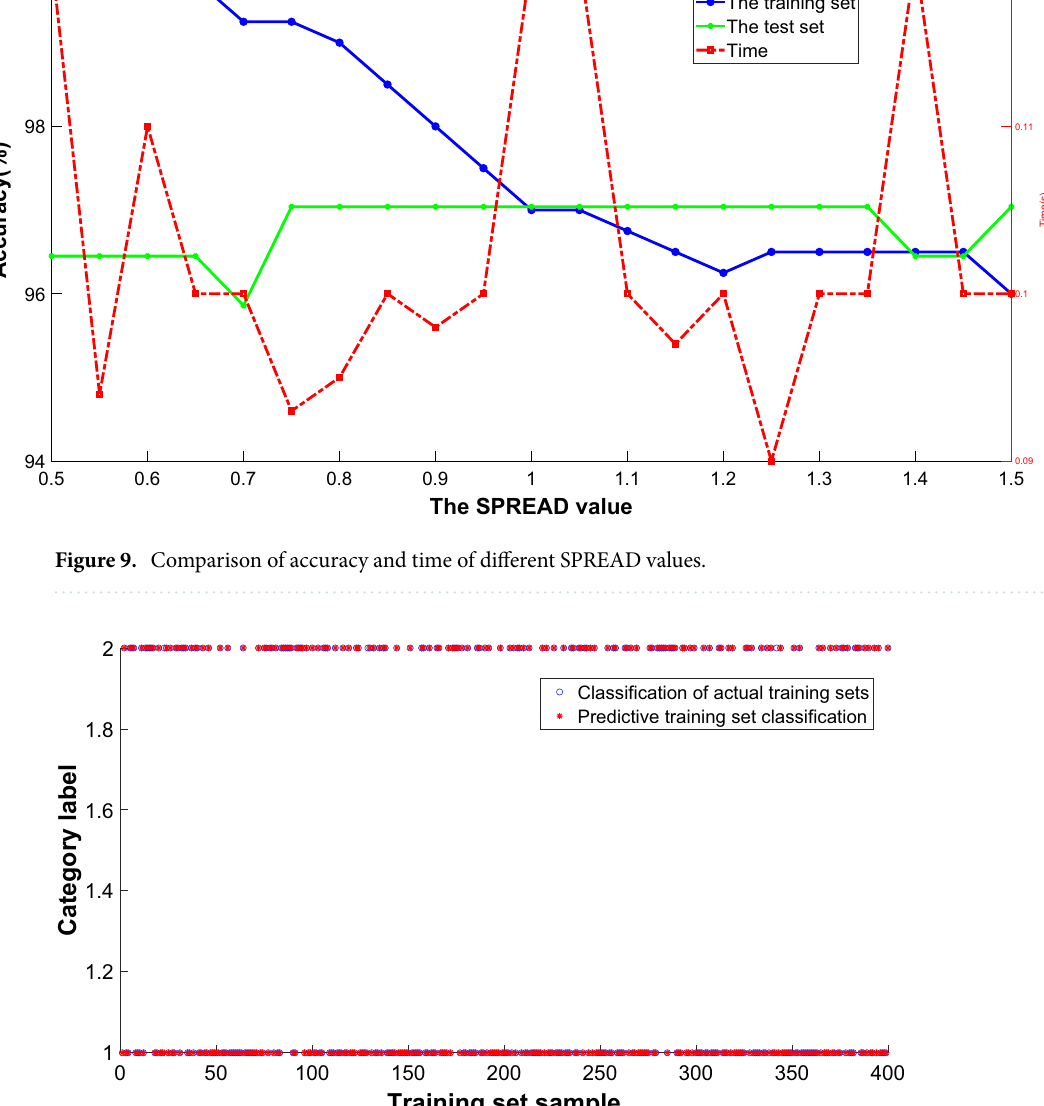
Figure 10. Training set classification